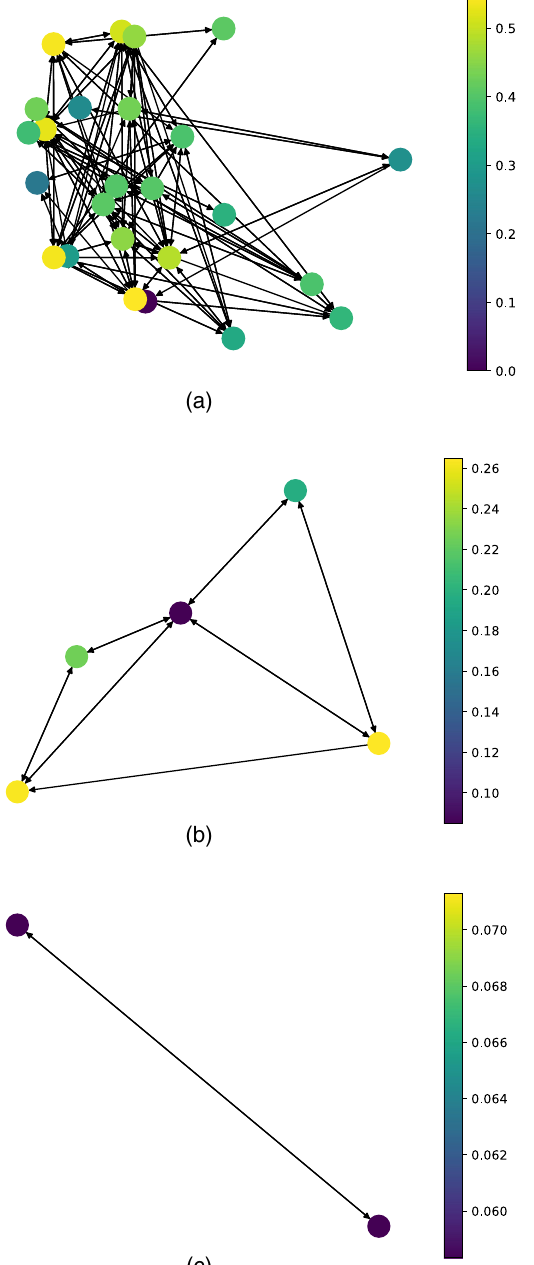
FIG. 5. The three components, representing three isolated groups of students, of the network from the Spring 2021 thermal physics course at CU Boulder. There were also 16 fully disconnected students who do not appear in the networks above. Nodes are colored based on the outward directed closeness centrality c Co . (a) First component of the collaboration network from the Spring 2021 thermal physics course at CU Boulder, (b) Second component of the collaboration network from the Spring 2021 thermal physics course at CU Boulder, and (c) Third component of the collaboration network from the Spring 2021 thermal physics course at CU